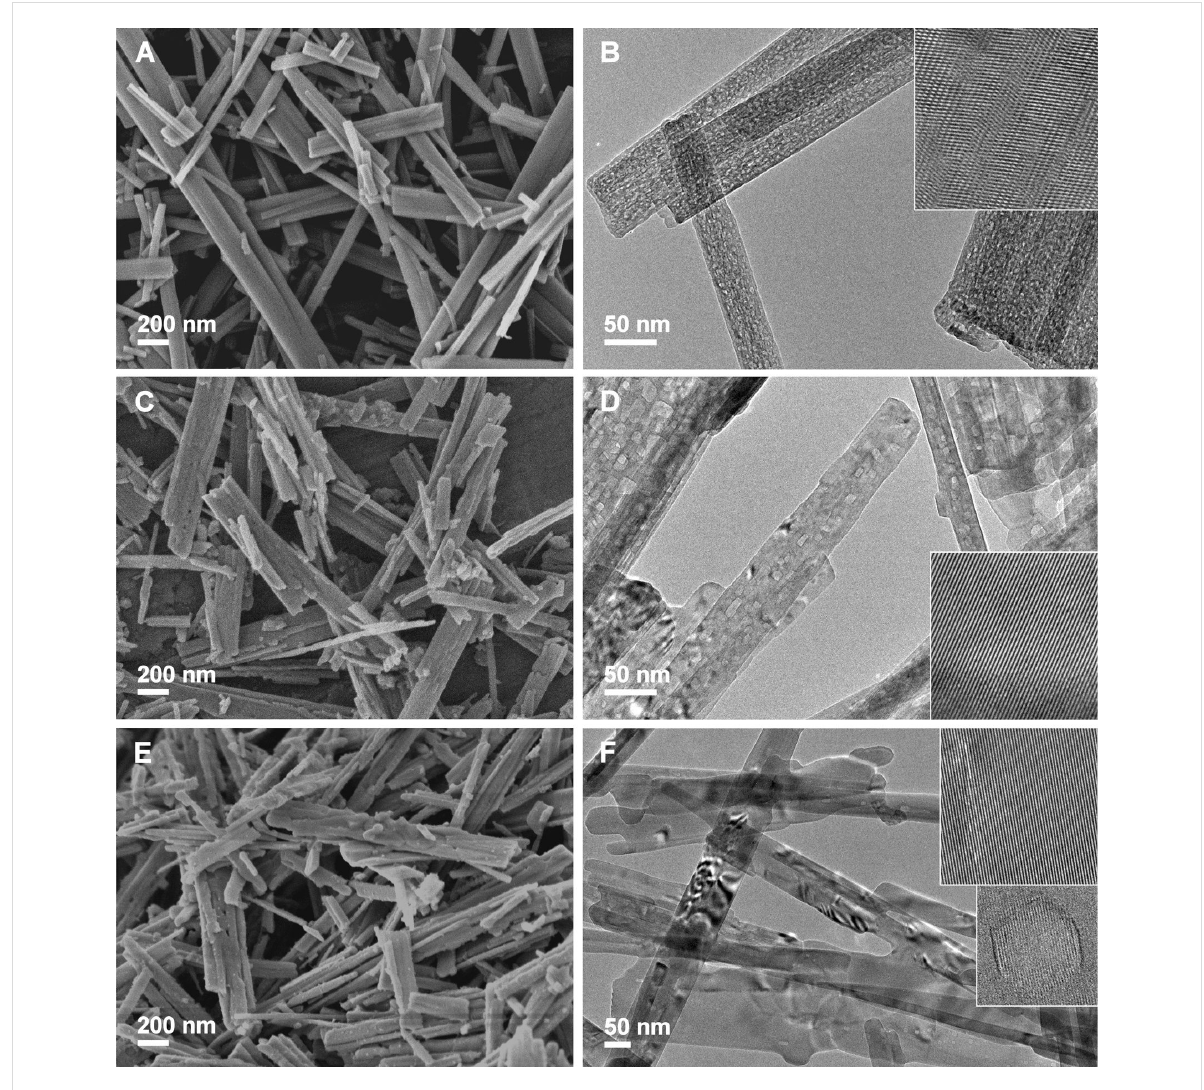
Figure 4: SEM and TEM images of TiO 2 nanoribbons derived from hydrogen titanate nanoribbon precursors by heat treatment in air at 400 °C (A and B), 580 °C (C and D), and 650 °C (E and F). The insets in figures B, D and F indicate the crystalline nature of the